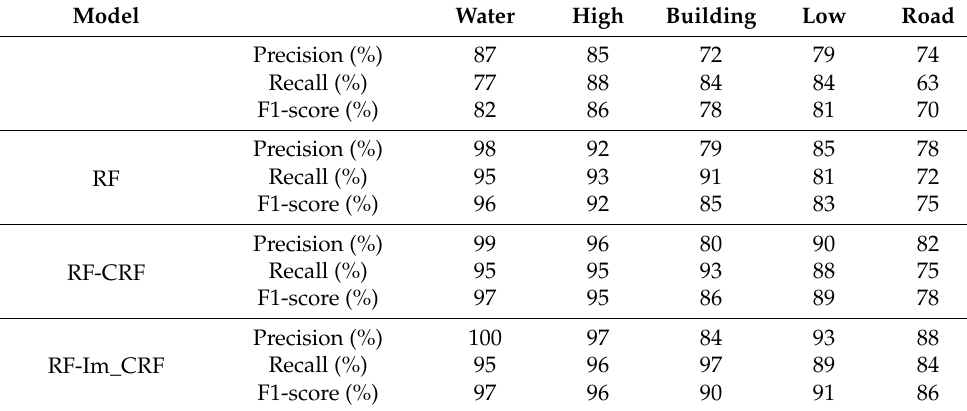
Table 3. Comparison of results of different